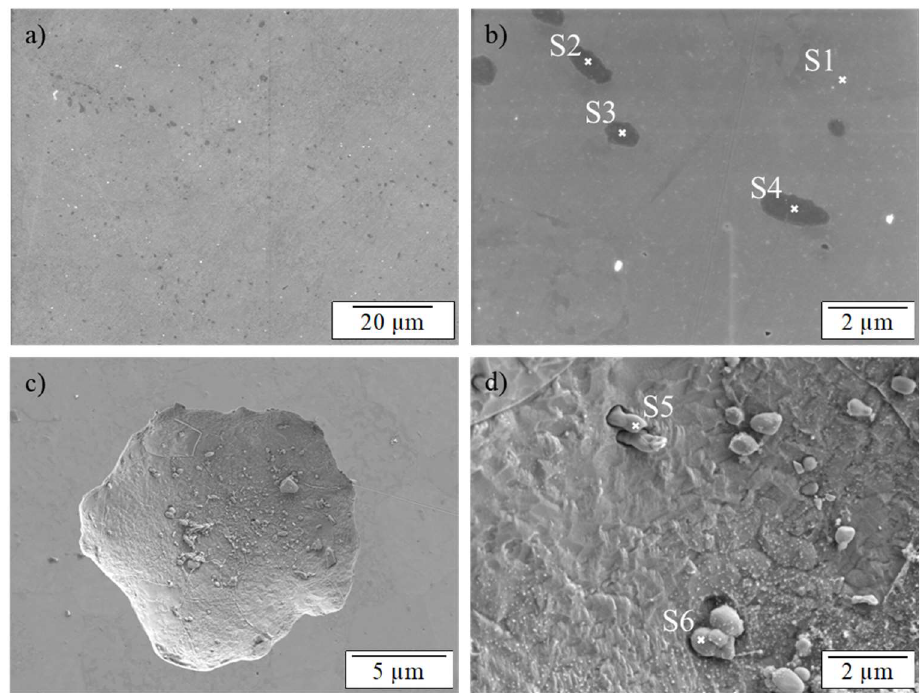
Figure 8. SEM image of the 1.4016 taken using the in-lens detector. ( a ) and ( b ) show chromium carbide/carbonitrides precipitates of a not-tested specimen; ( c ) a stable corrosion pit; ( d ) a view inside the pit shown in ( c ). Table 4. Selected results of the EDS analysis of the points S1–S6 in Figure 8b, wt % assumed with relative scatter of ±5 %.